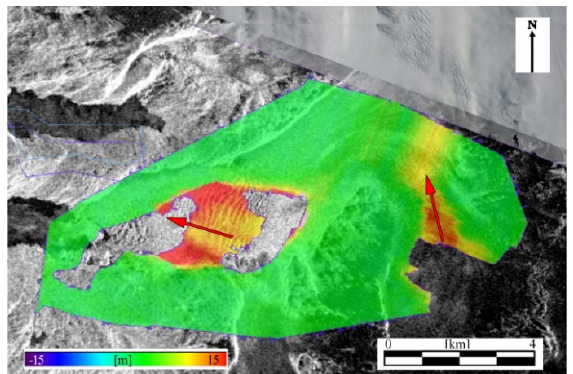
Figure 7. Asia glacier displacement map.